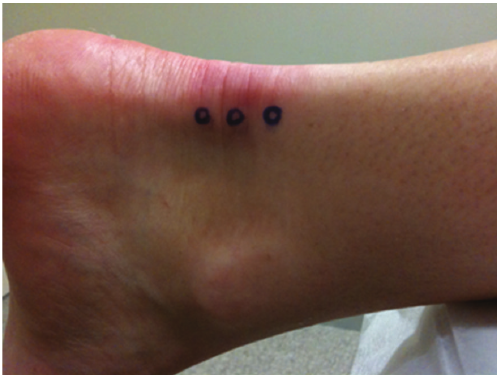
Figure 3: Injection sites for Achilles tendon.